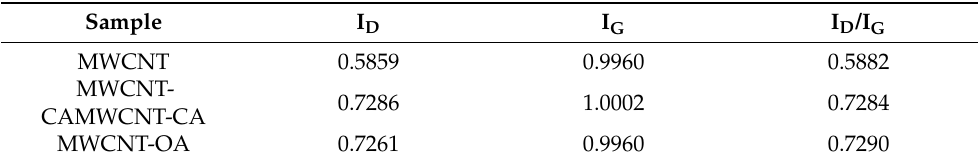
Table 1. I D /I G ratio of MWCNT, MWCNT-CA and MWCNT-OA obtained by Raman spectroscopy.